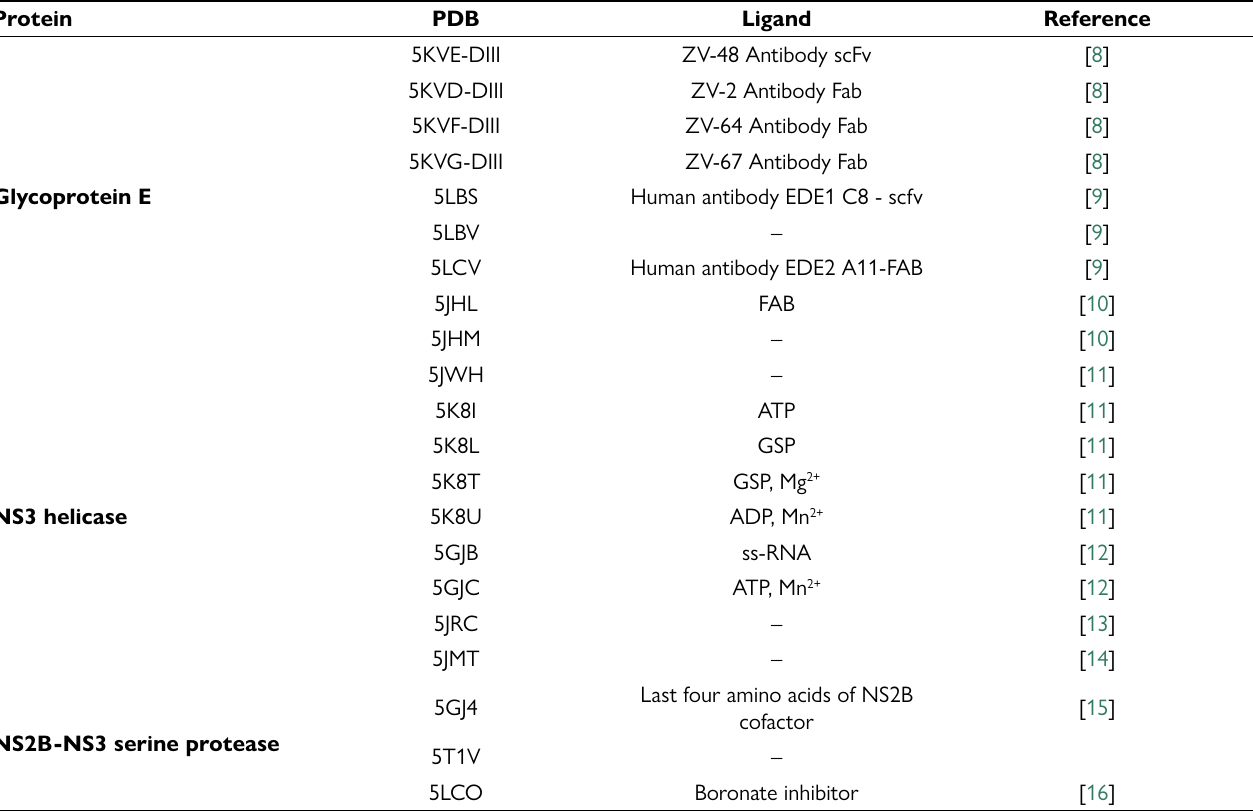
Table 1. Structural information on Zika virus proteins Protein